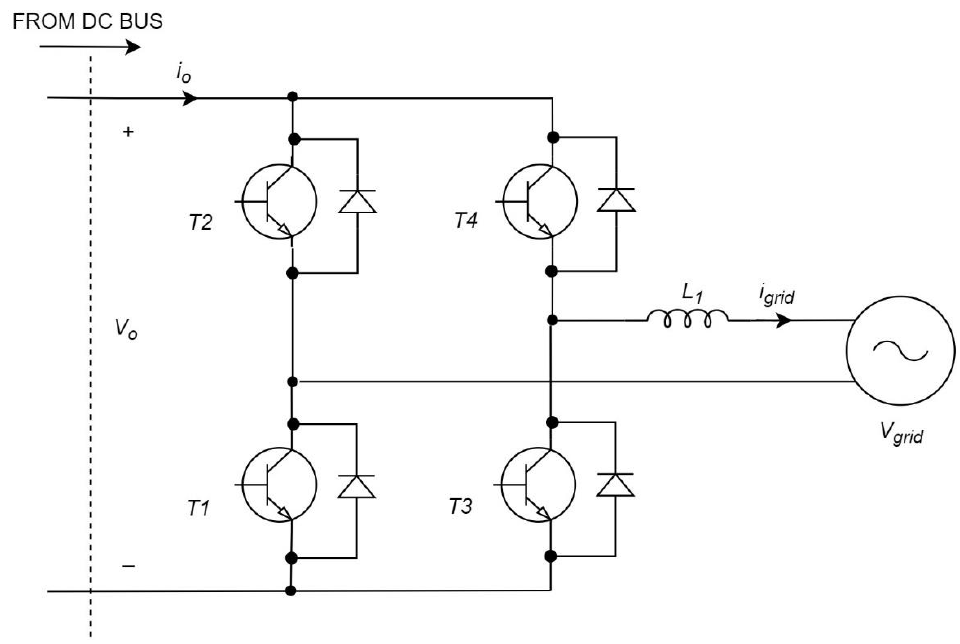
Figure 5. Topology of the inverter.